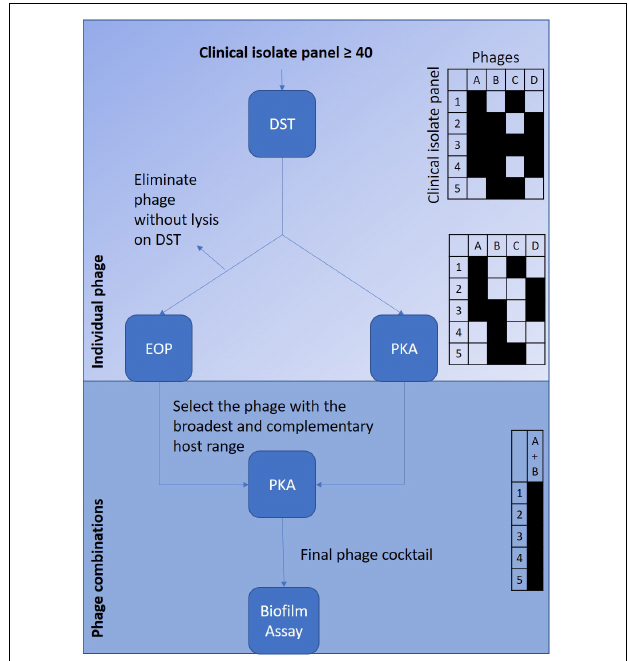
FIGURE 6 | Depicts the suggested selection processes to screen a phage library against a clinical isolate collection to optimise development of a potentially therapeutic phage cocktail. The left sided route suggests starting with the screening of the individual phages via the DST followed by EOP to confirm host-range. The right sided route suggests starting initially screening the individual phages with the DST followed by the PKA to confirm host-range. Both routes are then followed by selection of the phages that have the broadest and complementary host range to combine to test in combinations against the clinical isolate collection with the PKA. The final phage combination will be then be tested in biofilm assay. The tables on the right hand of the figure are to depict examples of the host-range coverage provided by each of the virulence